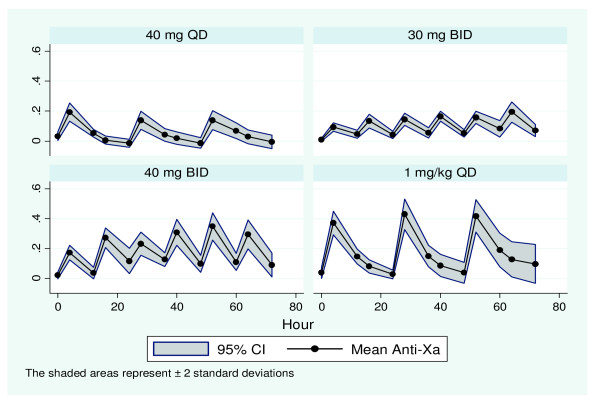
Variation in anti-factor Xa over time for each dose of enoxaparin.